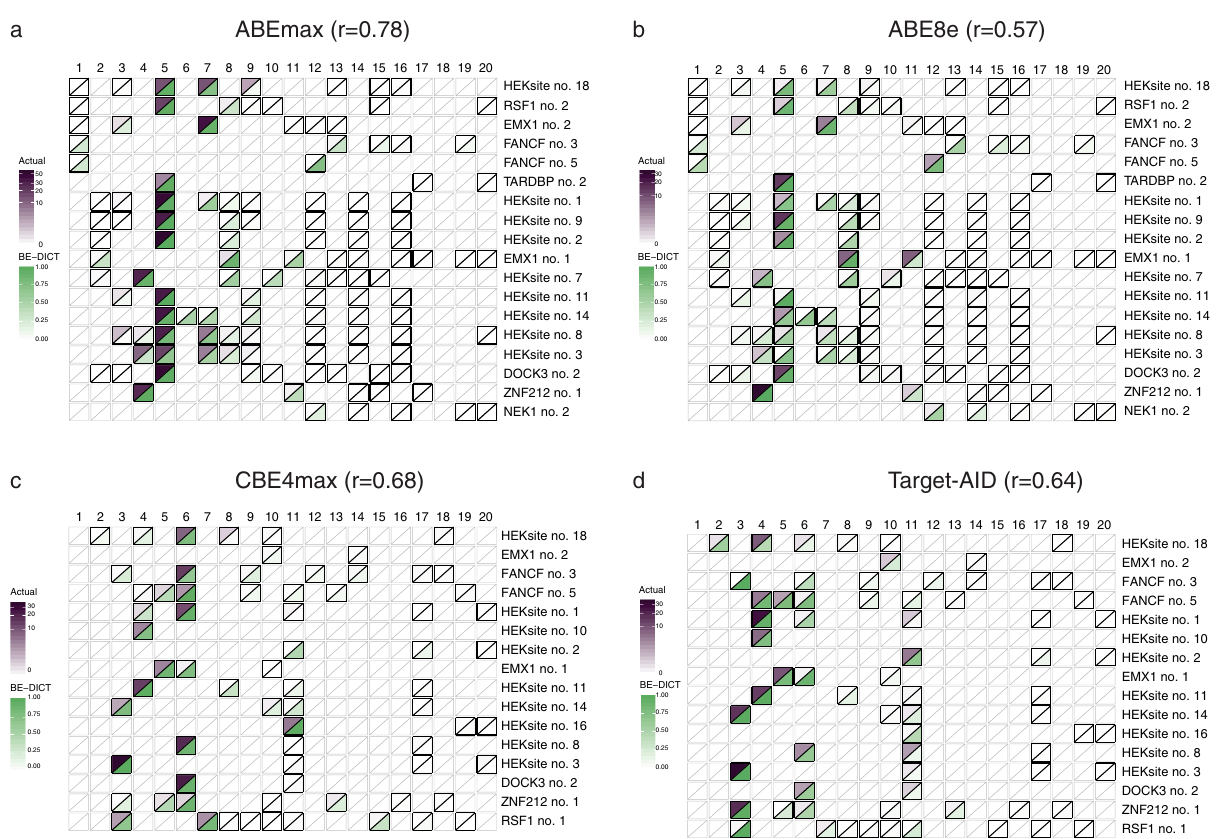
Fig. 3 BE-DICT accurately predicts base editing activities on endogenous genomic loci in HEK293T cells. Endogenous genomic target sequences with at least two substrate nucleotides were targeted separately by co-transfection of the sgRNA and base editors a ABEmax, b CBE4max, c ABE8e, and d Target- AID. Heatmap shows the BE-DICT prediction score (green) and experimentally observed target base conversion (purple). Substrate bases for the respective base editor are outlined in bold. Pearson ’ s correlation ( r ) for all target bases is